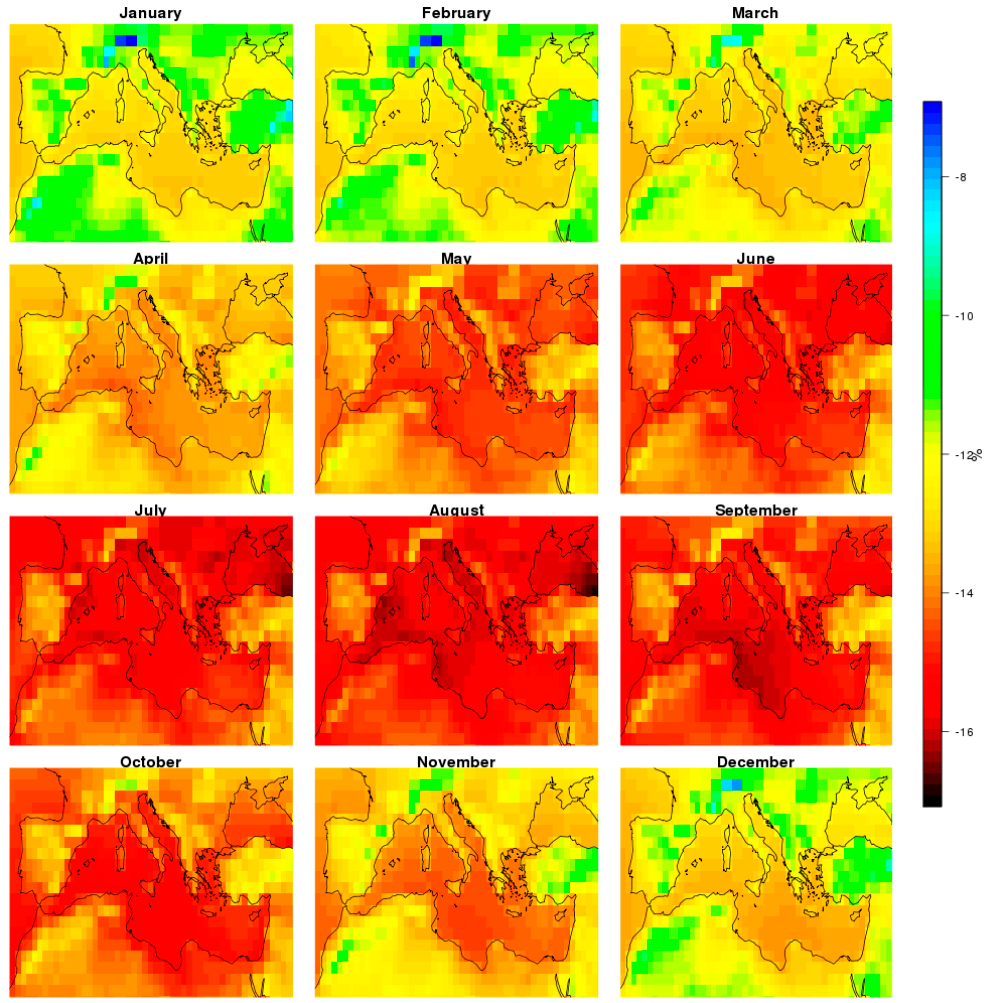
Figure 5. Distribution of monthly averaged PWV effects on shortwave radiation at the surface in the Mediterranean basin during the period 2000–2018. All figures have the same scale.